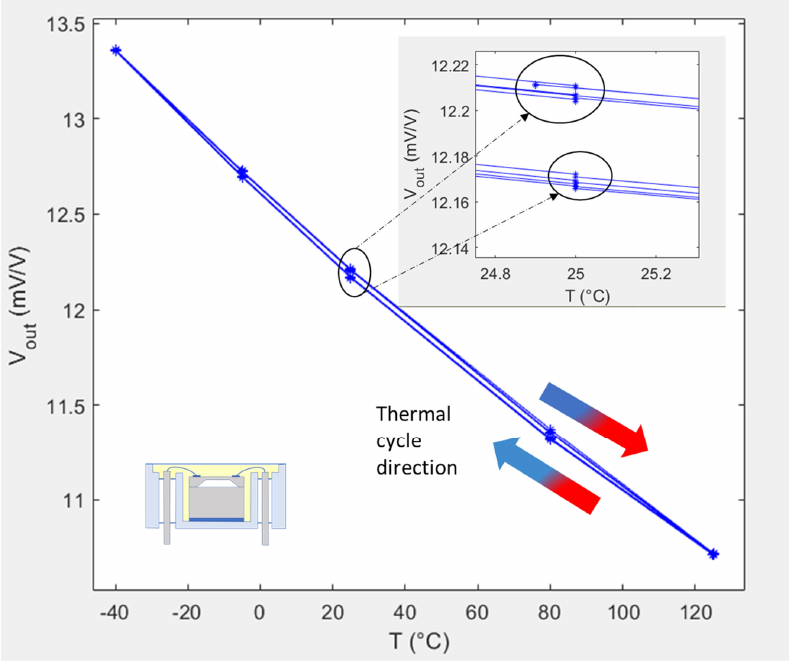
Figure 2. Voltage output response at 100 kPa for one of the L2 packaged sensors used in this study and subjected to multiple thermal cycles from − 40 to 125 °C. subjected to multiple thermal cycles from − 40 to 125 ◦ For the sensor showcased in Figure 2, the hysteresis, H, at 25 °C and 100 kPa during the first cycle can be calculated as the difference between the output voltage, V out ↗ , at 25 °C, when approached from cold at 100 kPa, and the output voltage, V out ↘ , at 25 °C, when approached from hot at 100 kPa. The hysteresis was therefore calculated as 45.5 μ V/V based on: